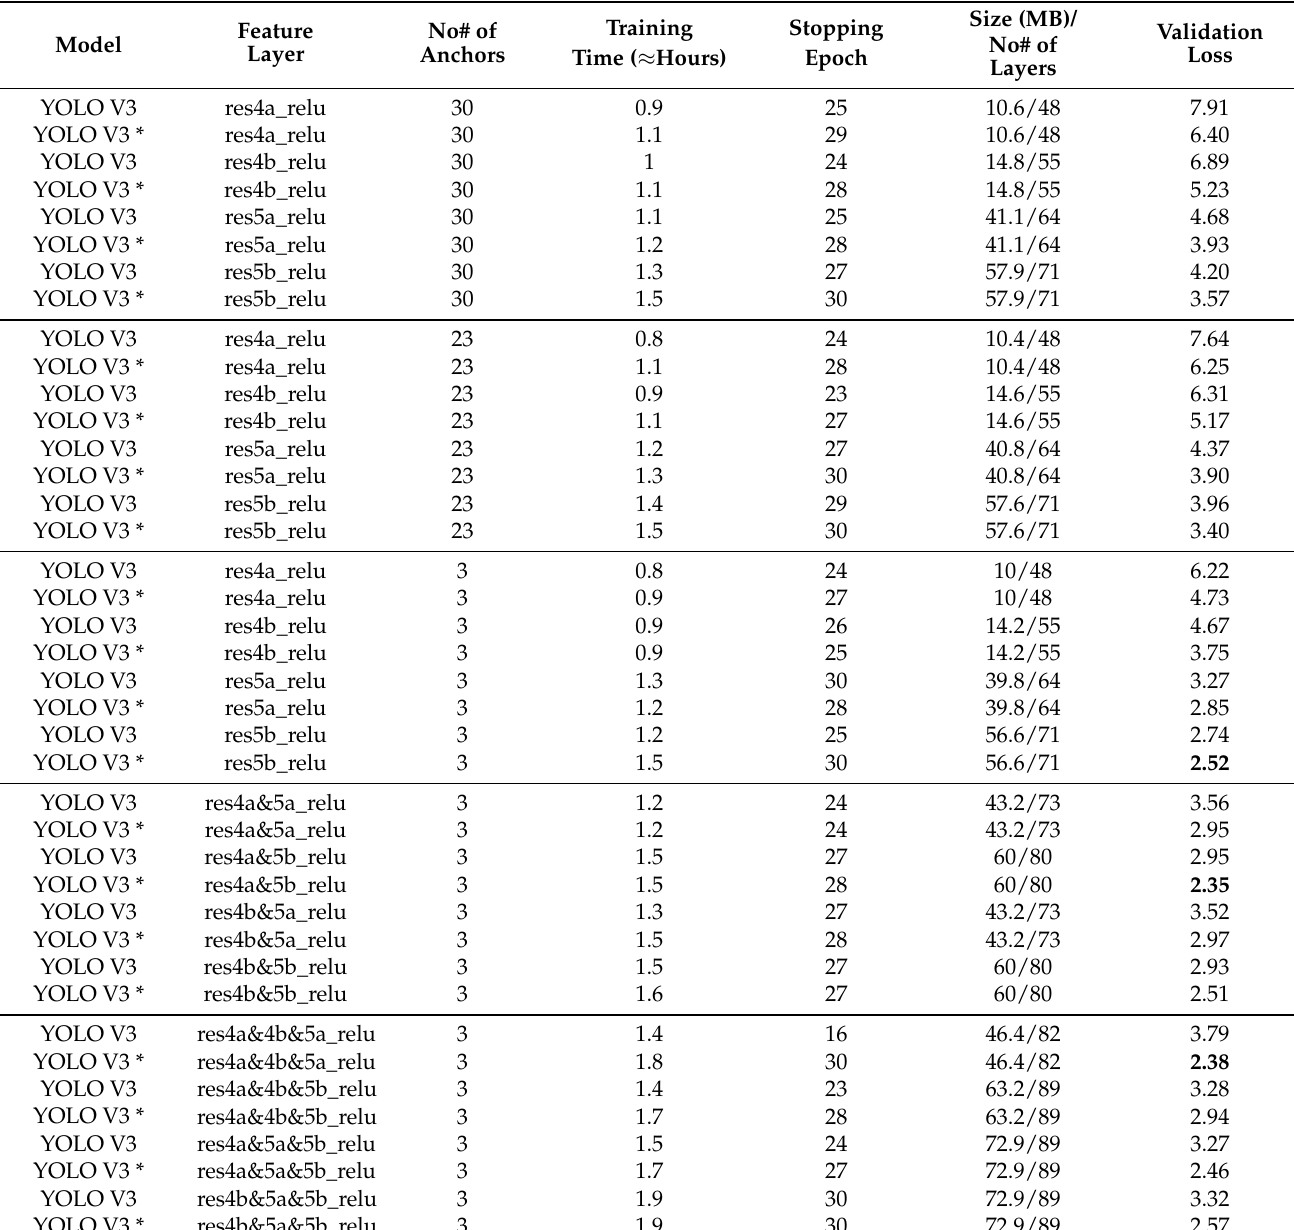
Table 3. Training details (YOLO V3 with ResNet-18 using mini-batch size of